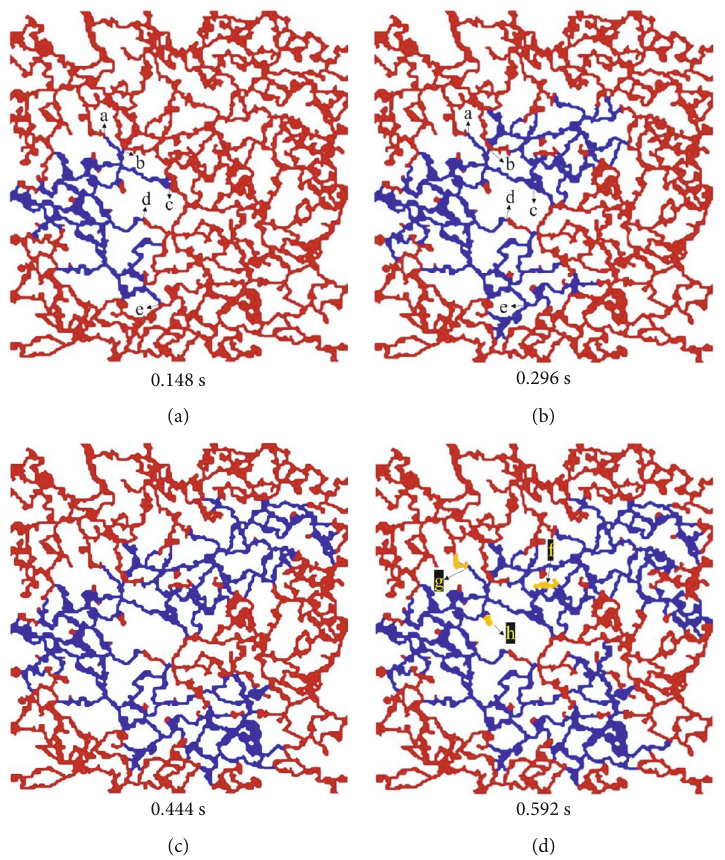
Figure 3: Oil and water two-phase distribution versus time. (a) 0.148s. (b) 0.296 s. (c) 0.444s. (d) 0.592s.